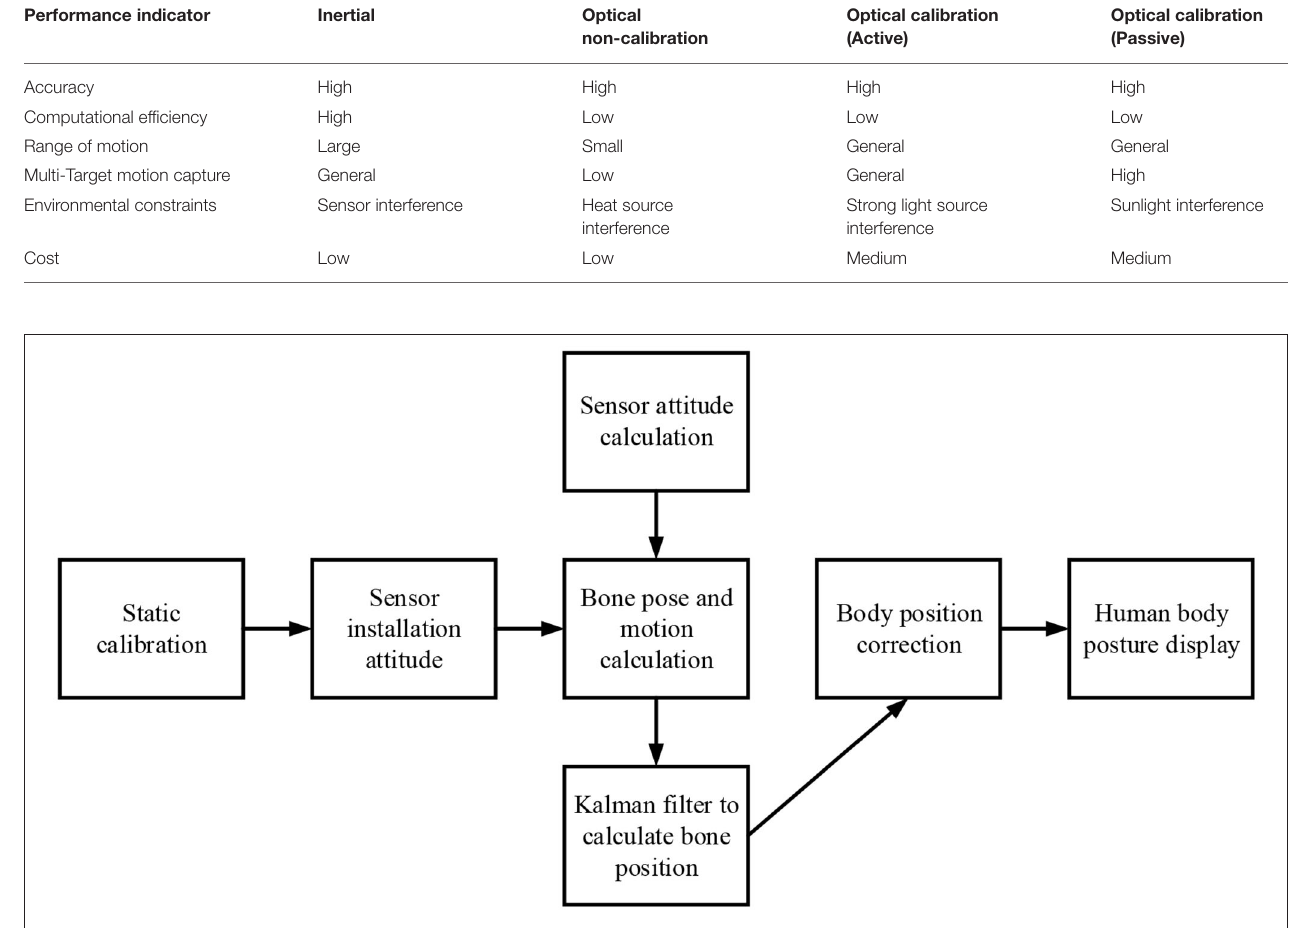
FIGURE 1 | The fundamental process framework of inertial motion capture technology.